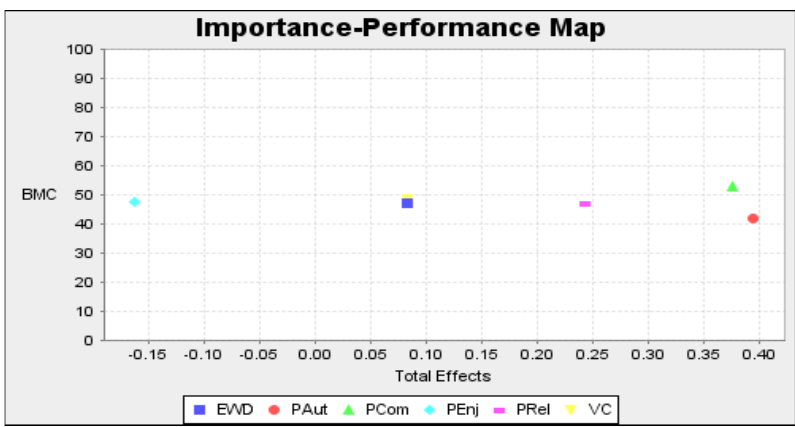
Figure 2 : Importance-Performance Map Analysis; Source: Adopted by